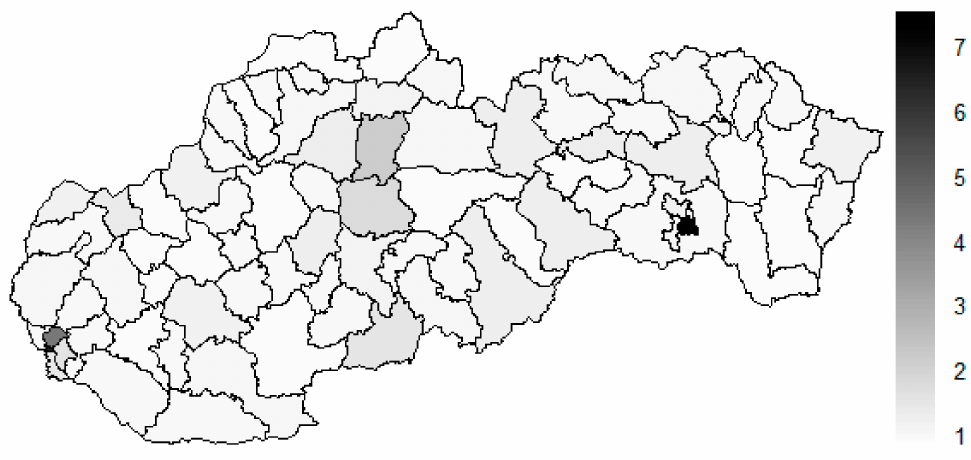
Figure 9. Medical equipment similarity map of the districts in the whole explored period. Source: own elaboration by the